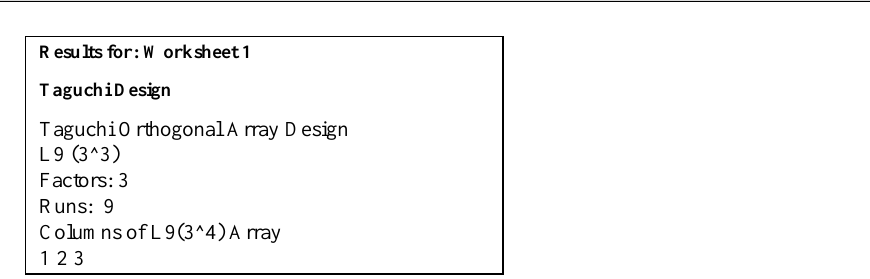
Fig. 8. Specifications of the used Taguchi method